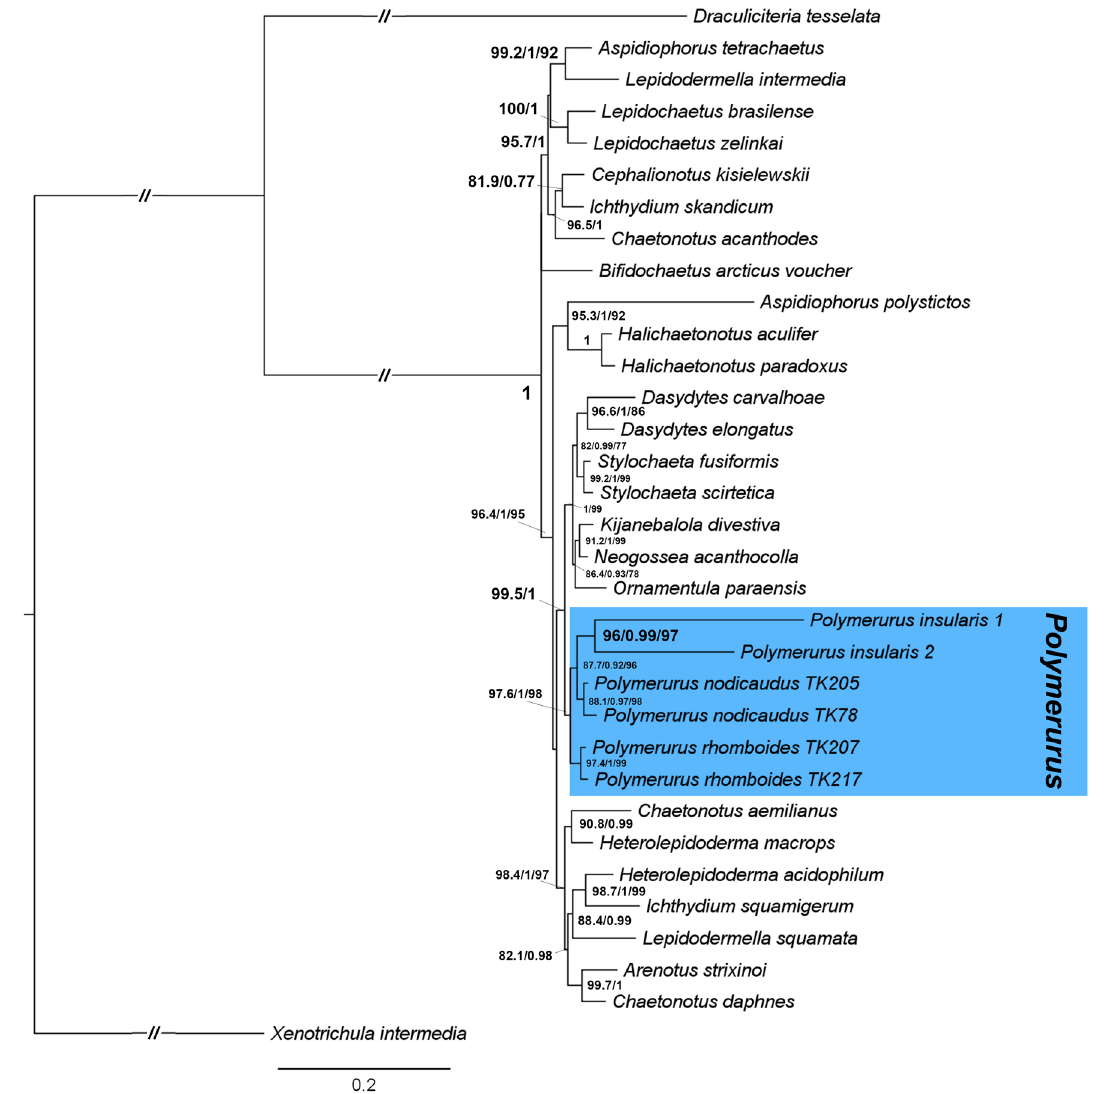
Fig. 9. Maximum Likelihood tree based on multigene approach with 18S and 28S sequences. Highlighted branches correspond to the Polymerurus Remane, 1927 species sequences. Values on the branches correspond, respectively, to: SH-aLRT support (%) / aBayes support / ultrafast bootstrap support